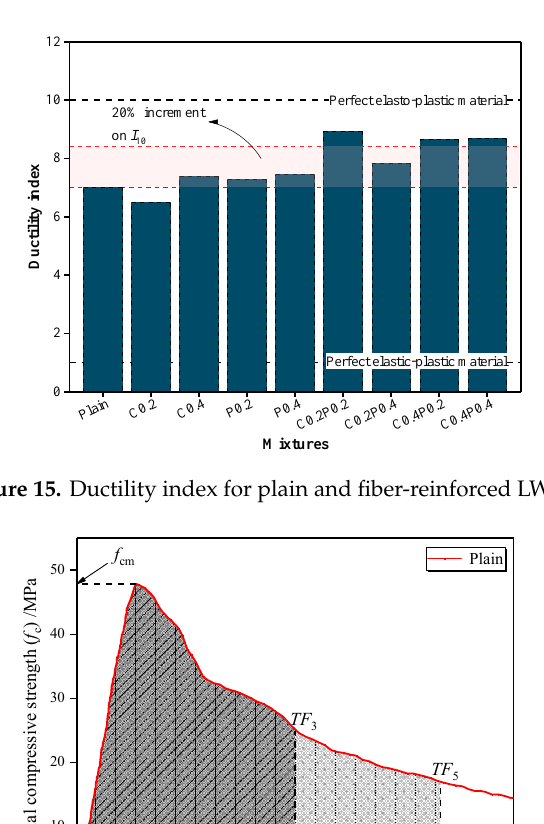
. Figure 17. Toughness ratio of plain and fiber-reinforced LWAC. After adding the hybrid carbon-polypropylene fibers, TR 3 and TR 5 of the LWAC increased by 16%–23% and 26%–37%, respectively. By comparing mixtures C0.2PP0.2 with C0.2PP0.4 and C0.4PP0.2 with C0.4PP0.4, a decrease in the toughness ratio can be observed under an increase in the polypropylene fiber content. Therefore, the increment of the polypropylene fiber reduces the effect of the hybrid fibers. However, such a reduction is significantly lower compared with an increase in the addition of the hybrid fibers. Taking the TR 5 value as an example, C0.2PP0.4 and C0.4PP0.4 generated an additional 26% and 38% toughness ratio when compared with the plain mixture. Therefore, the LWAC reinforced with hybrid fibers showed a much greater toughness ratio than those with a single fiber, which indicates their higher energy-absorbing capacity. Moreover, the increase in toughness ratio can be explained by the flat descending part of the stress–strain curve.